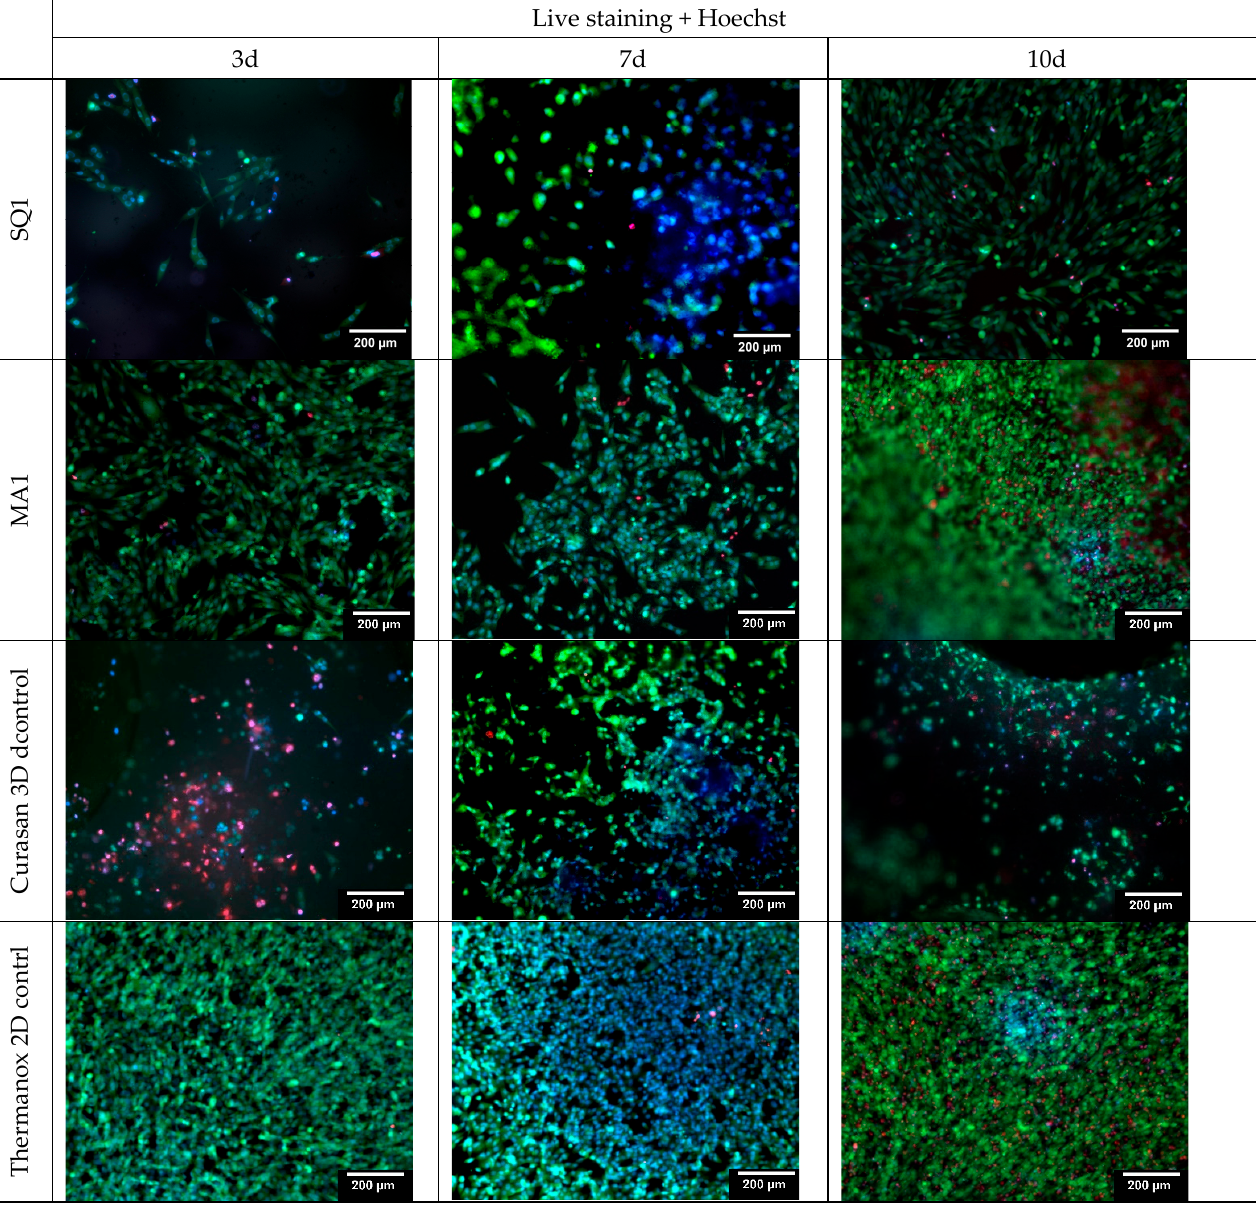
Figure 11. Live/dead and Hoechst staining for the different samples (including the 3D cell culture control on Curasan ceramics as well as 2D cell culture control on Thermanox cover slip); Hoechst (blue) staining of cell core (DNA) of living cells; green = living and red dead cells (live/dead staining).